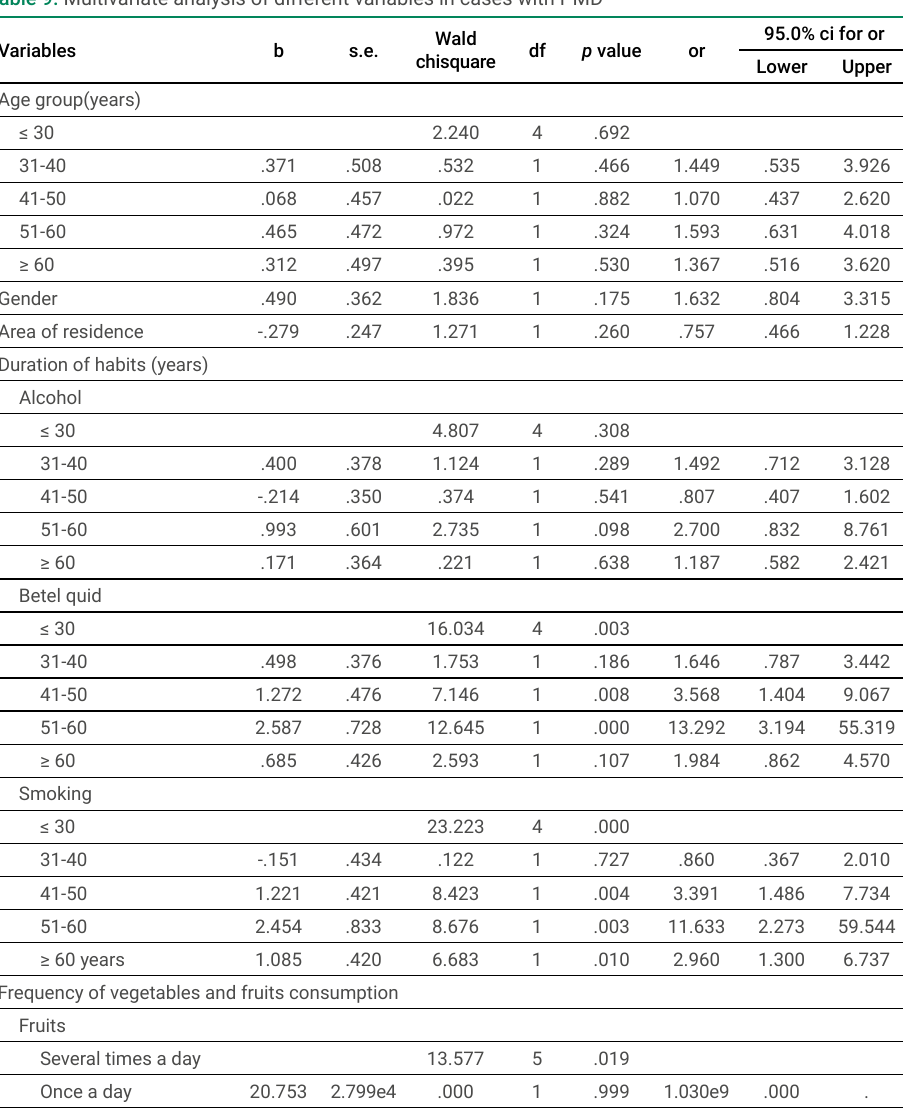
Table 9. Multivariate analysis of different variables in cases with PMD Variables b s.e.